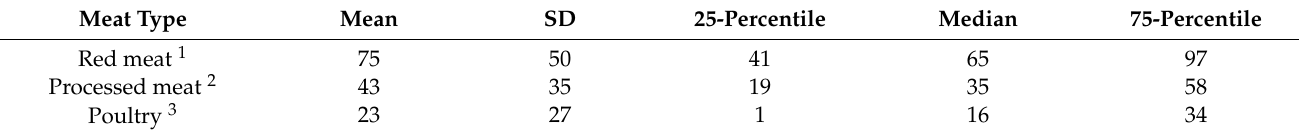
Table 2. Distribution of meat intake (g/day) in the total study population, n =